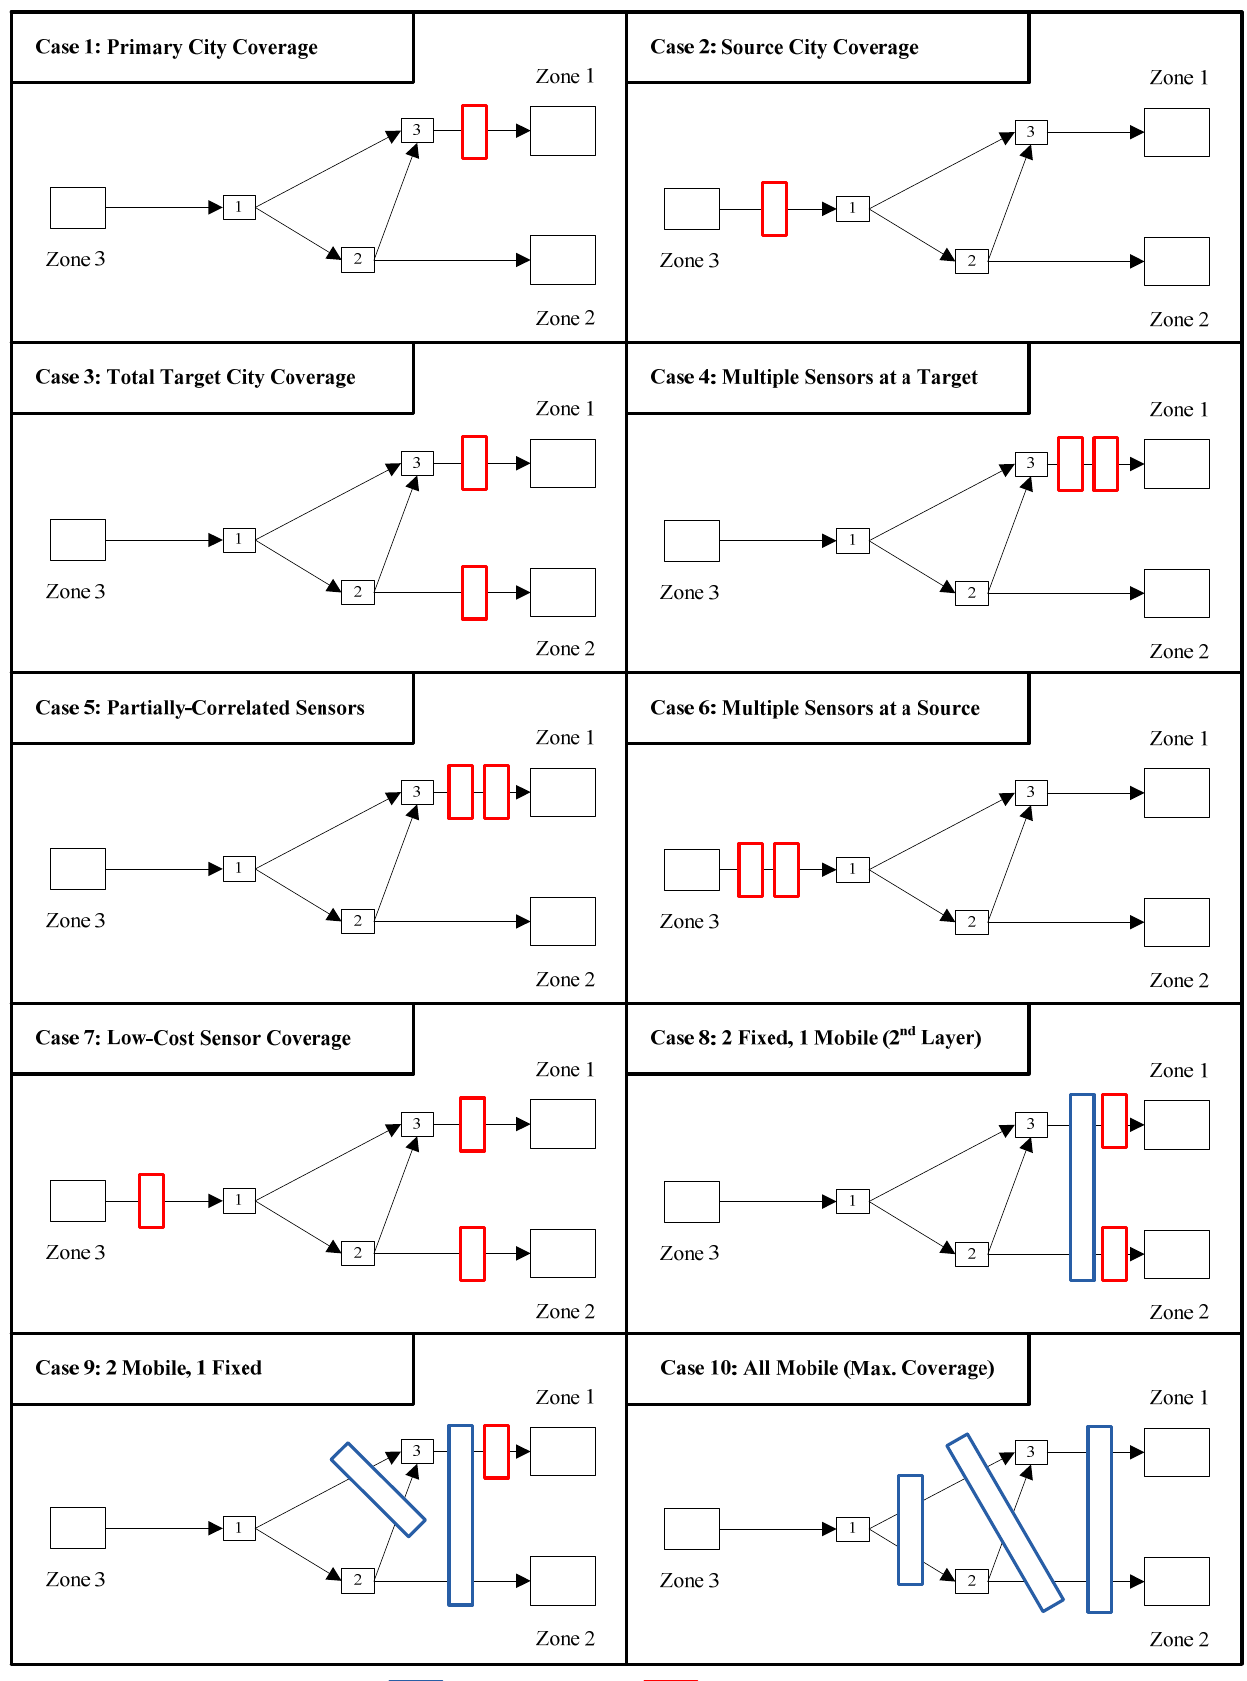
Figure 5. Illustrative examples for cases